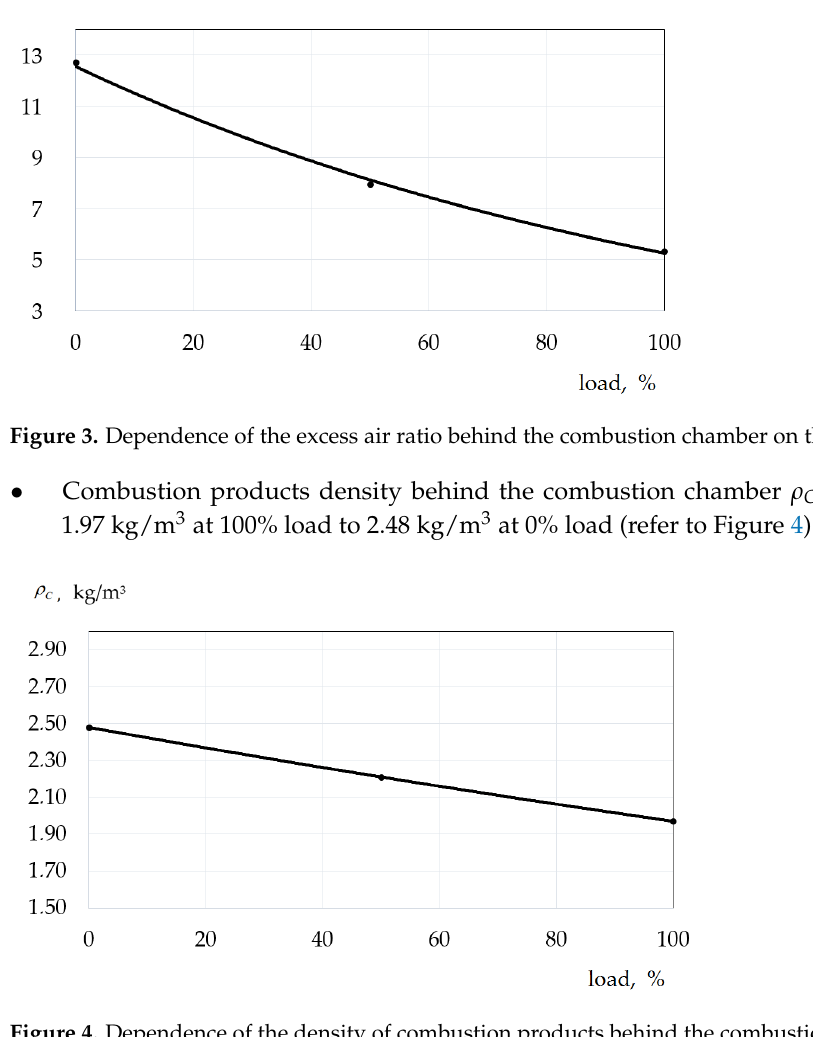
Figure 2. Dependence of the average mass heat capacity of gases at α = 1 on the load value.